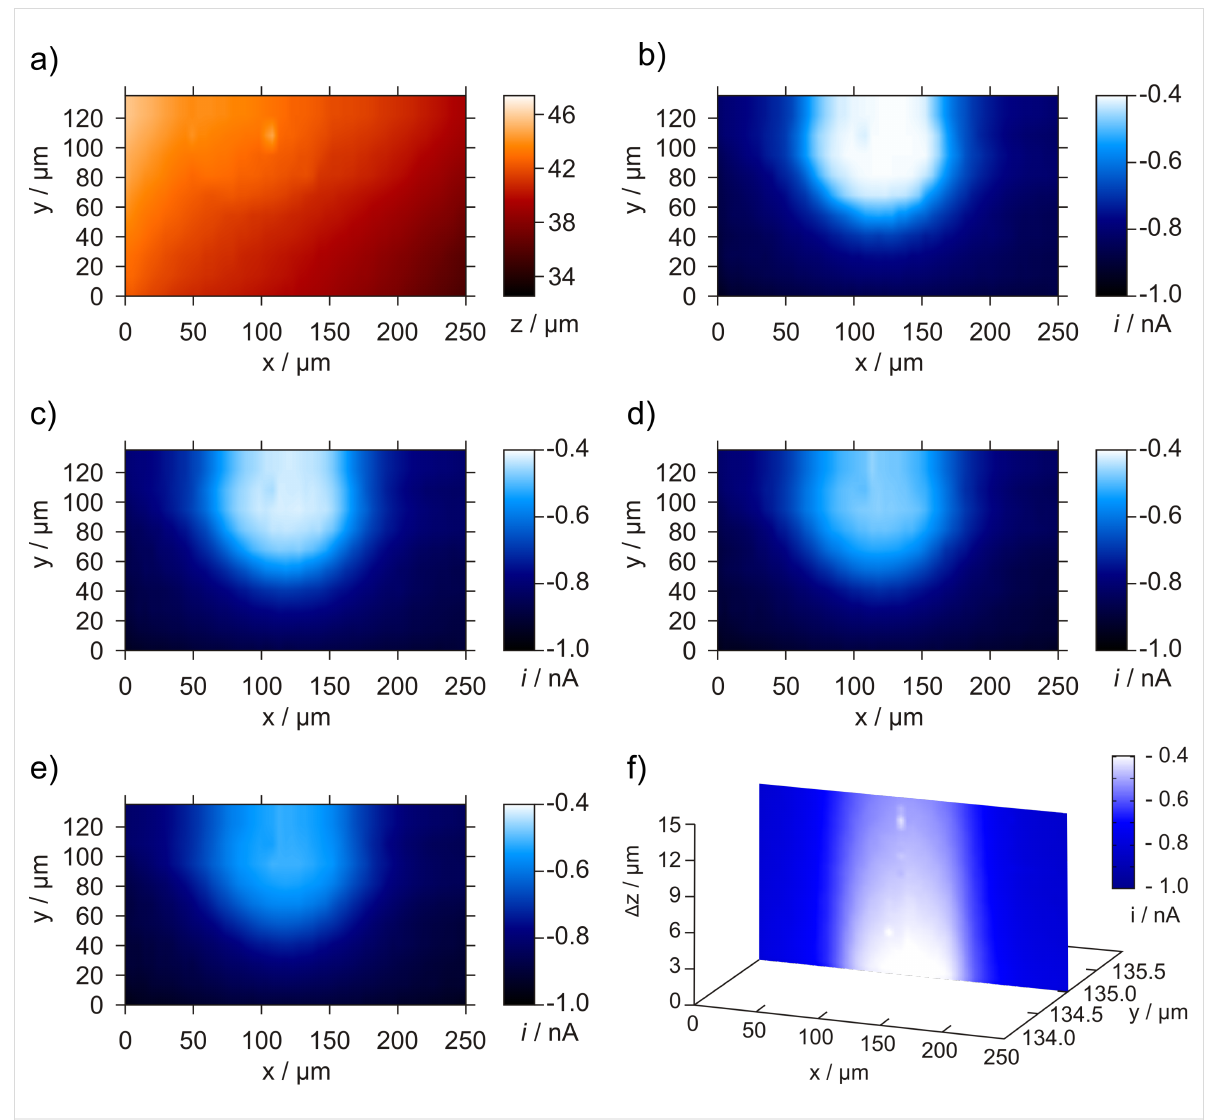
Figure 5: 4D SF/CD-RC-SECM experiment at a 100 µm diameter Pt disk electrode as model sample for an ORR catalyst. a) Topography image, b)–e) horizontal current image at the point of shearforce contact and in increments of 5 µm after tip retraction. f) Oxygen consumption profile